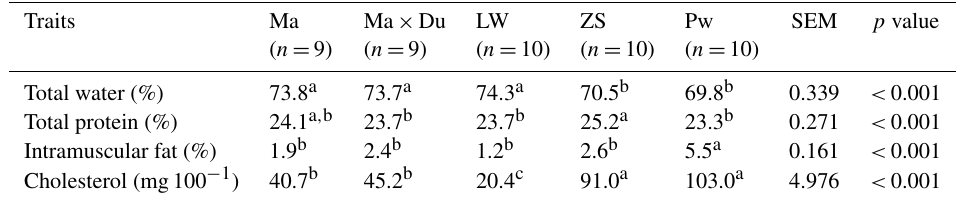
Table 7. The chemical properties in Musculus longissimus dorsi of genotypes. Traits